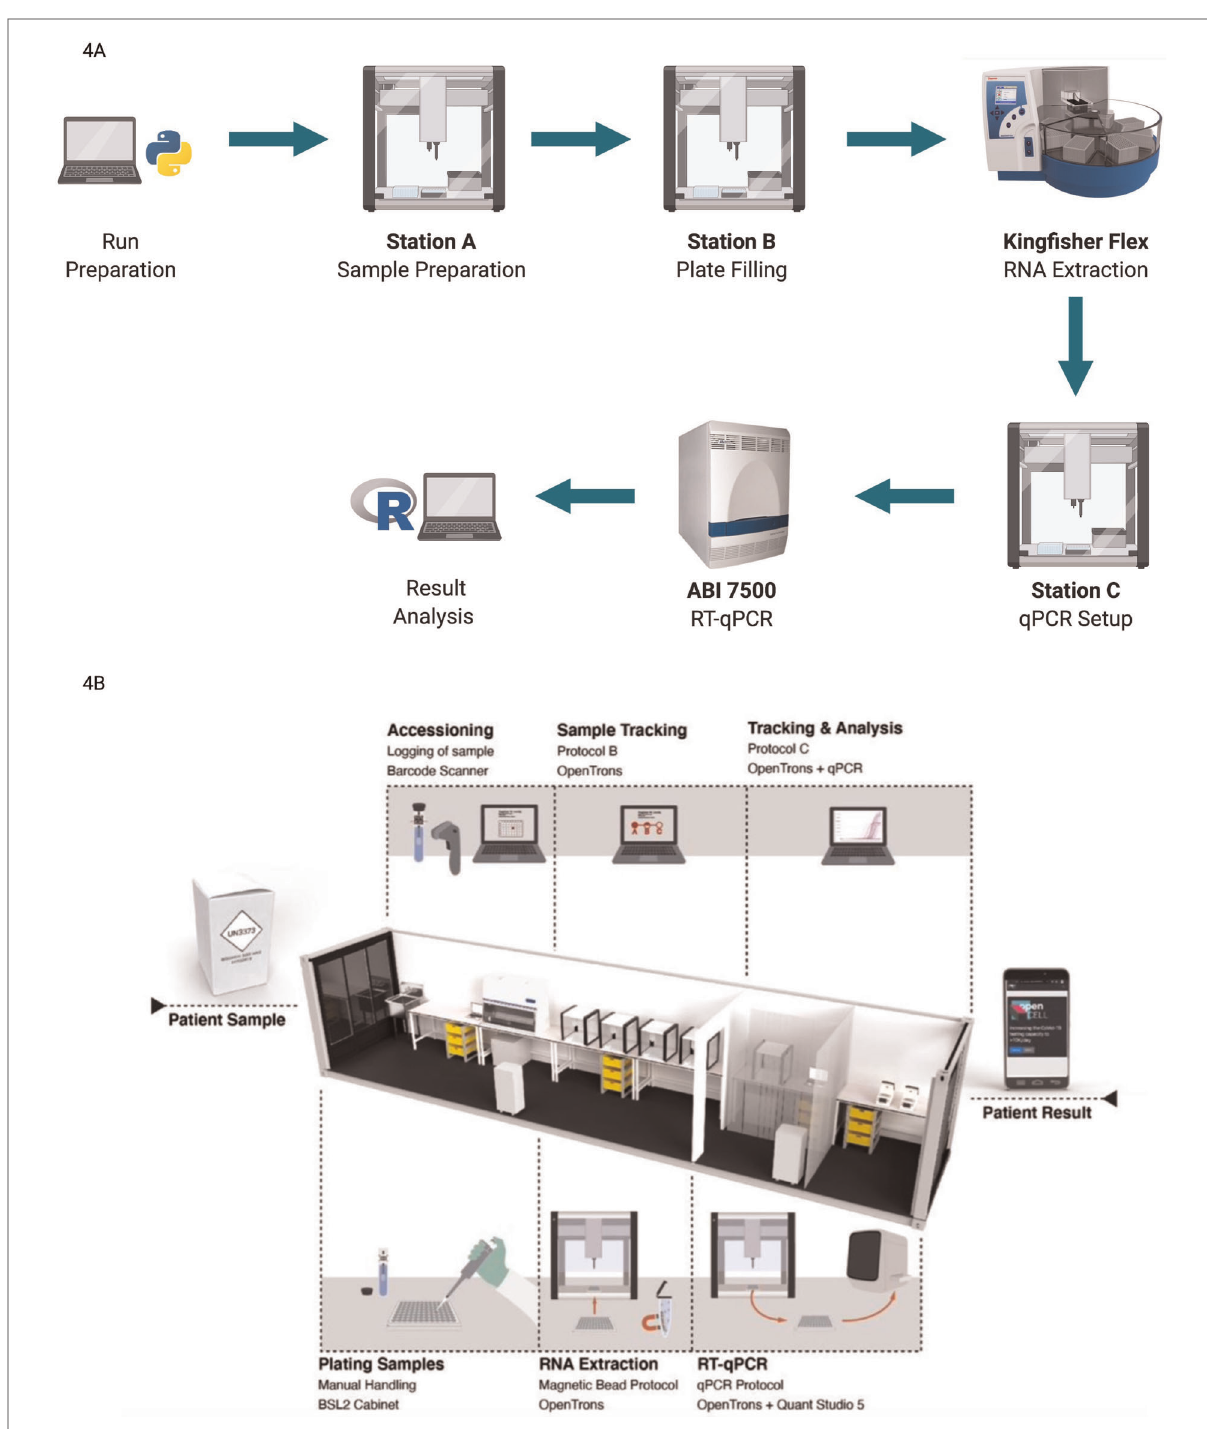
FIGURE 4 (created with BioRender.com). Different protocols using the open-source OT-2 automated platform for COVID-19 testing ( A ) automated work fl ow Designed at CBD. An initial run preparation was performed using open-source Python coding. Initial sample setup, sample preparation, and plate fi lling and qPCR mix preparation were performed by OT-2 robots. RNA extraction was processed by KingFisher Flex and RT- qPCR was run by ABI 7500. Analysis results were exported as a user-friendly R fi le. Figure adapted from Villanueva-Cañas et al. (33) ( B ) the layout and work fl ow of a semi-automated CONTAIN lab. Three separate sections were used for plating samples, RNA extraction and RT-qPCR respectively. OT-2 robots were used for the RNA extraction process and qPCR mix preparation. Station C which is used for the RT-qPCR run also contained two subsections to separate OT-2 and qPCR devices. Image taken from OpenCell.bio, Walker et al.